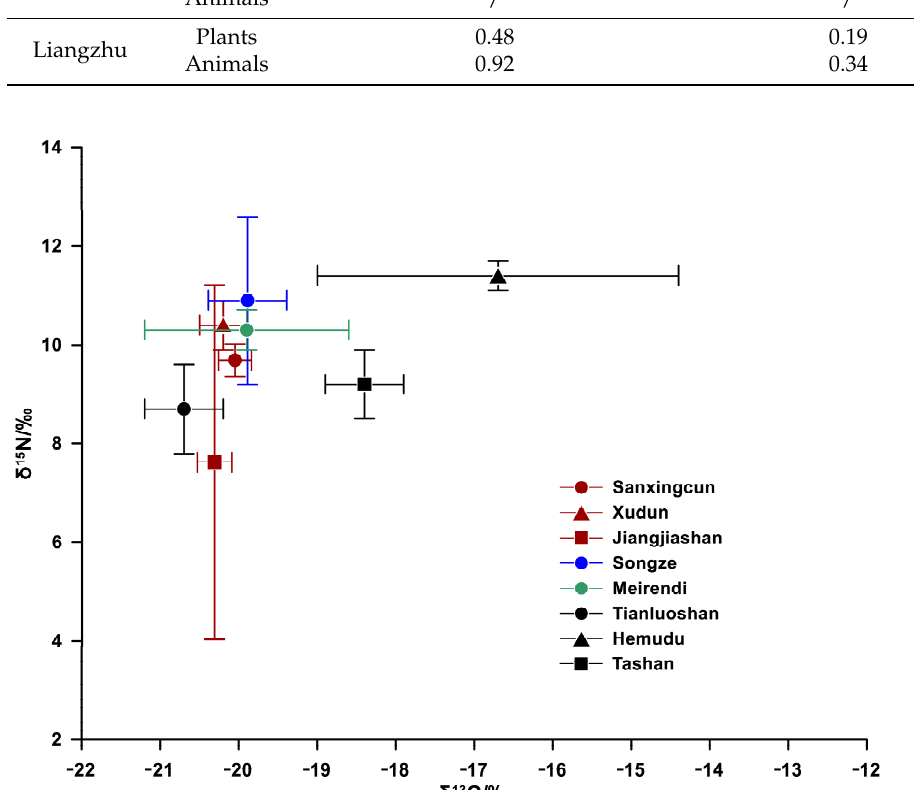
Figure 2. Scatter plot of δ 13 C and δ 15 N values of human bones from the area around Taihu Lake and Ningshao Plain. The red, blue, green, and black marks indicate the sites of the Majiabang, Songze, Liangzhu, and Hemudu Cultures, respectively. Majiabang and Zhuangqiaofen sites were not in- cluded in this figure because of the lack of δ 15 N values, which can be seen in Table